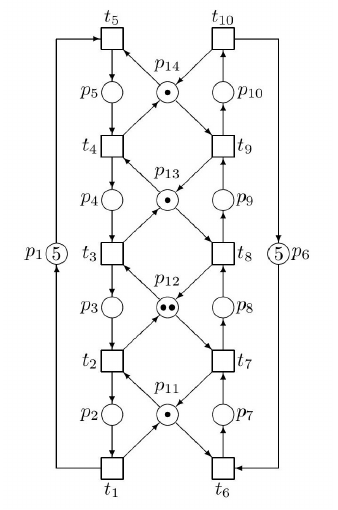
is not connected as it is clear from the 1